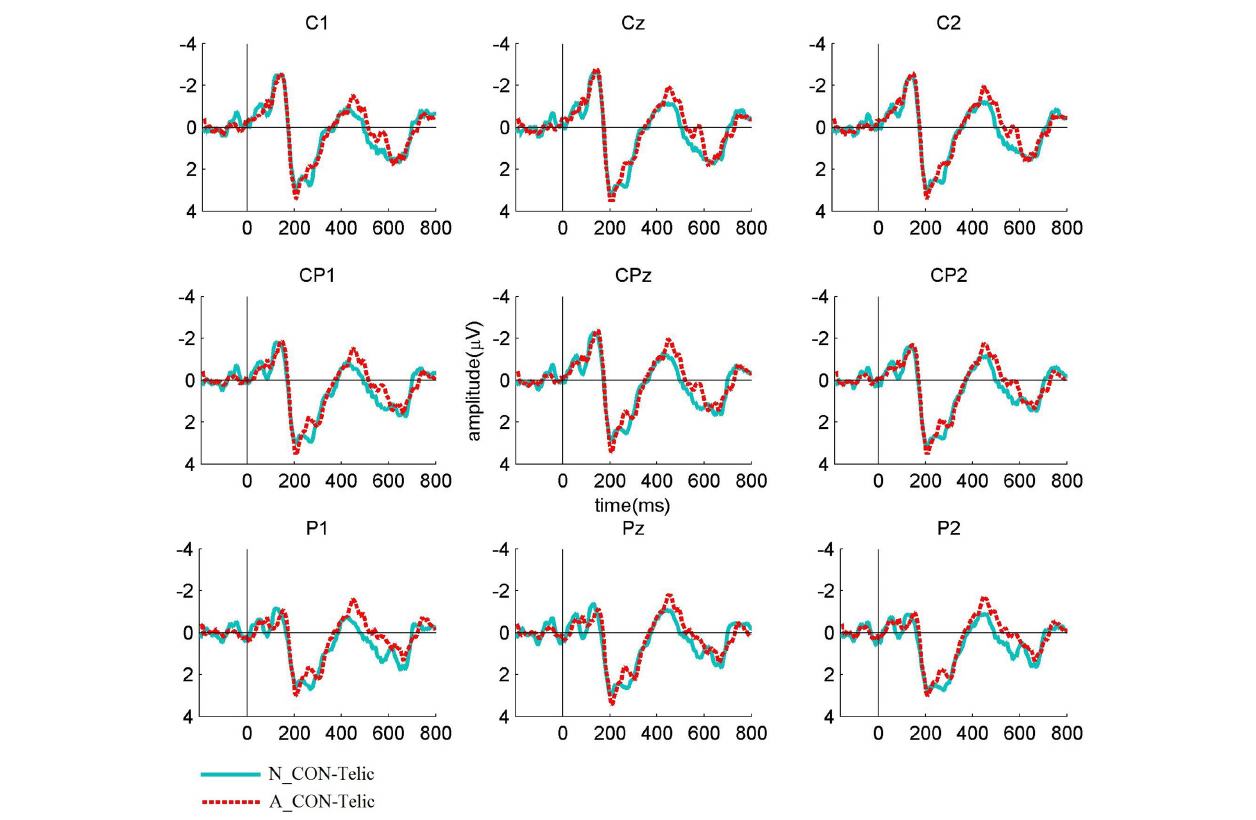
FIGURE 3 | Grand average waveforms elicited by the verbs in Telic combinations for Neutral contexts vs. ad-hoc affordance-inducing contexts over nine centro-parietal channels. The waveforms show that the N400 component for the verbs in the Telic combinations is significantly enhanced in A_CON compared to